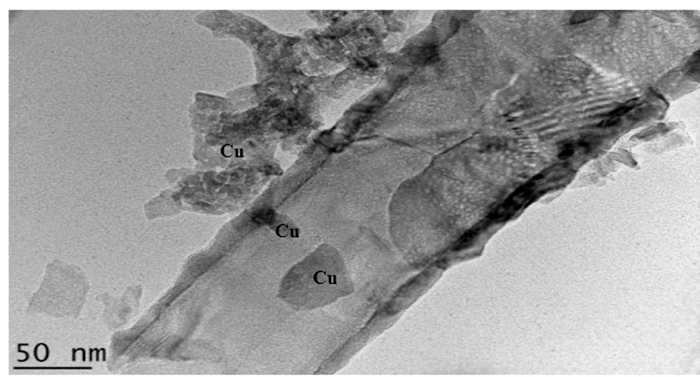
Figure 8. Transmission electron microscopy (TEM) image shows cross sectional morphologies of CuTiO 2 NTs labelled